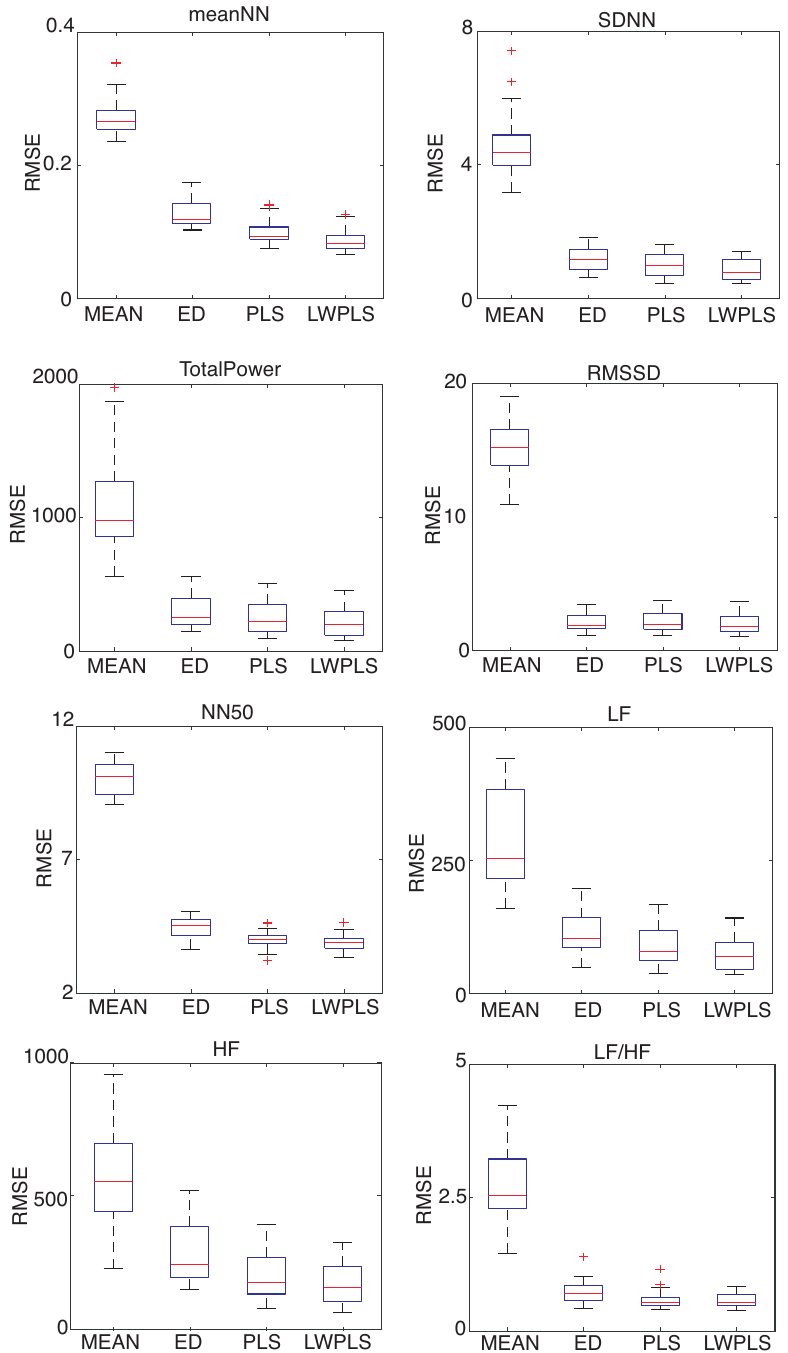
Figure 7. RMSE of HRV features derived from RRIs interpolated by MEAN, ED, PLS, and LWPLS when α = 0.5%. These eight HRV features were explained in the Appendix A. RMSEs of the four methods were calculated through a simulation repeated 30 times using all of the eighteen pieces. The proposed LWPLS-RI achieved the best HRV analysis